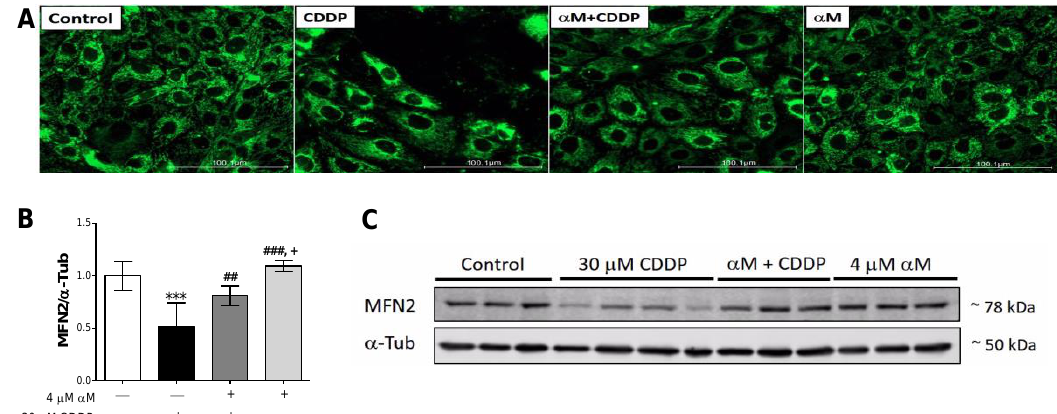
Figure 5. CDDP-induced toxicity is related to a decrease in mitochondrial proteins. LLC-PK1 cells were treated with α M, CDDP or both for 24 h. After treatment, western blotting of total oxidative phosphorylation (OXPHOS) cocktail in the whole cell ( A – D , F ) voltage-dependent anion channel (VDAC) as mitochondrial mass markers were quantified and ( E , G ) representative protein expression is shown. Densitometry values were normalized by Ponceau red staining. The data are presented as mean ± SD, n = 4–8. *** p < 0.001, ** p < 0.01 and * p < 0.05 vs. control. +++ p < 0.001 vs. ( α M + CDDP). NDUFB8 = NADH: ubiquinone oxidoreductase subunit B8, SDHB = succinate dehydrogenase complex iron–sulfur subunit B, MTCO1 = mitochondrial cytochrome c oxidase I catalytic subunit, ATP5A = ATP synthase F subunit alpha, α -Tub = alpha-tubulin.